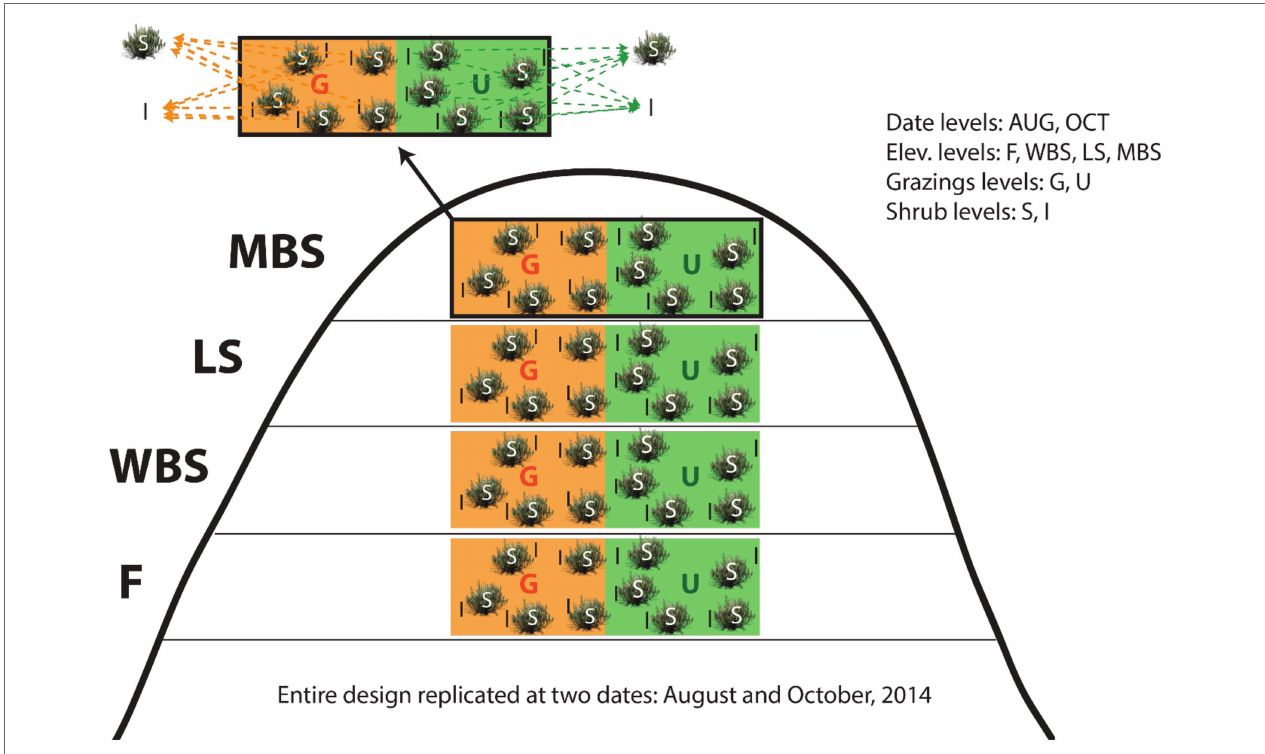
FIGURE 2 | Study experimental design for collecting biological soil crusts (BSCs) and underneath soil samples. Note the split-split plot design structure: shrub levels (split-split plots) within grazing levels (split-plot) within elevation levels (whole-plots) within date blocks (whole plot replicates). G, grazed plots; U, ungrazed plots (exclosure for >40 years); S, shrub plots; I, intershrub